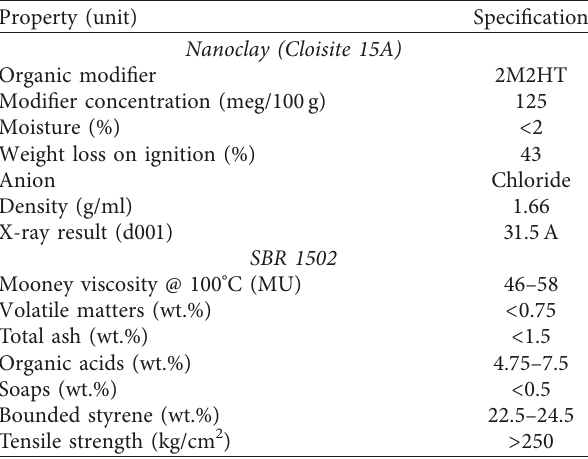
Table 2: Modifiers’ properties.